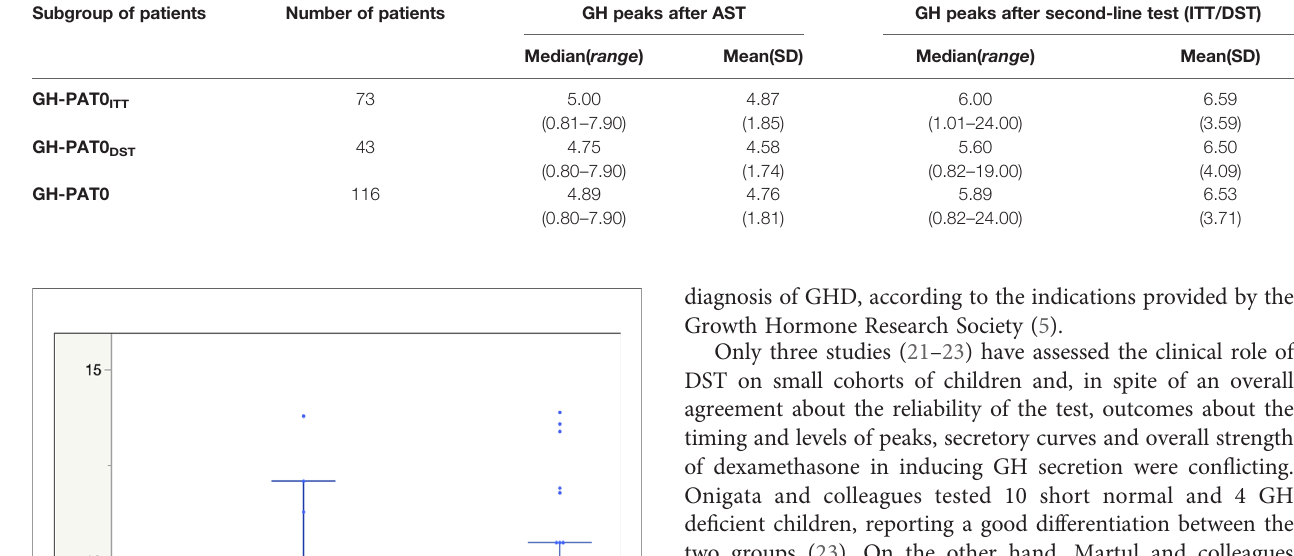
TABLE 4 | Median and mean GH peaks achieved after AST and ITT / DST in the GH-PAT0 ITT and GH-PAT0 DST subgroups. Subgroup of patients